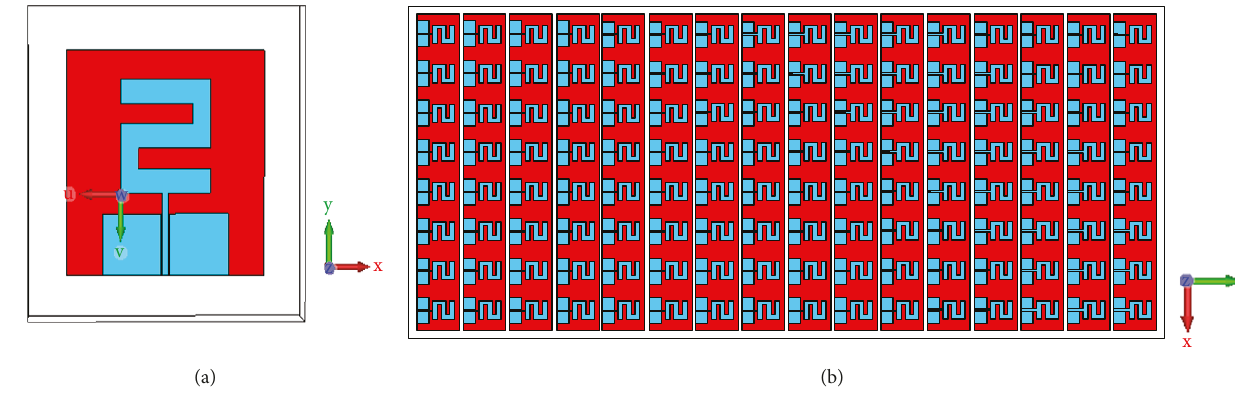
Figure 5: (a) Single Z-shaped CPW monopole antenna. (b) Array of 128 Z-shaped CPW monopole